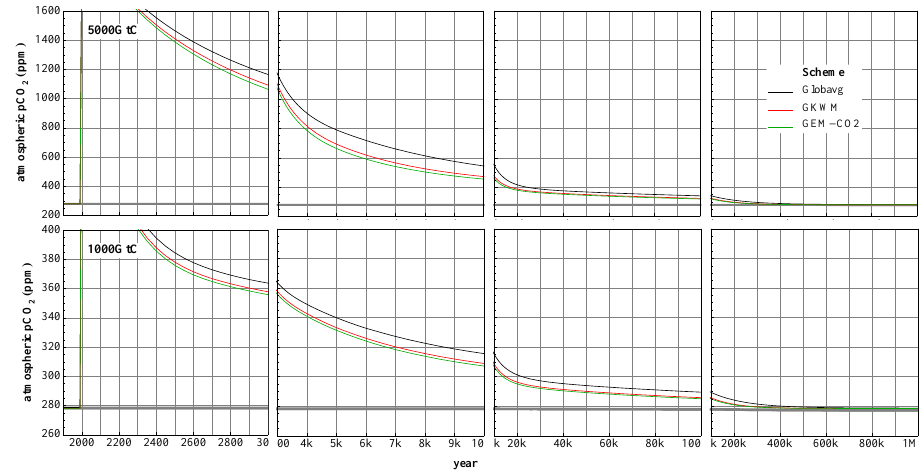
Fig. 20. Evolution of atmospheric CO 2 over 1 Myr for 1000 GtC (bottom) and 5000 GtC (top) emissions pulses, vs. a control run with no emissions (grey lines), for different weathering schemes.